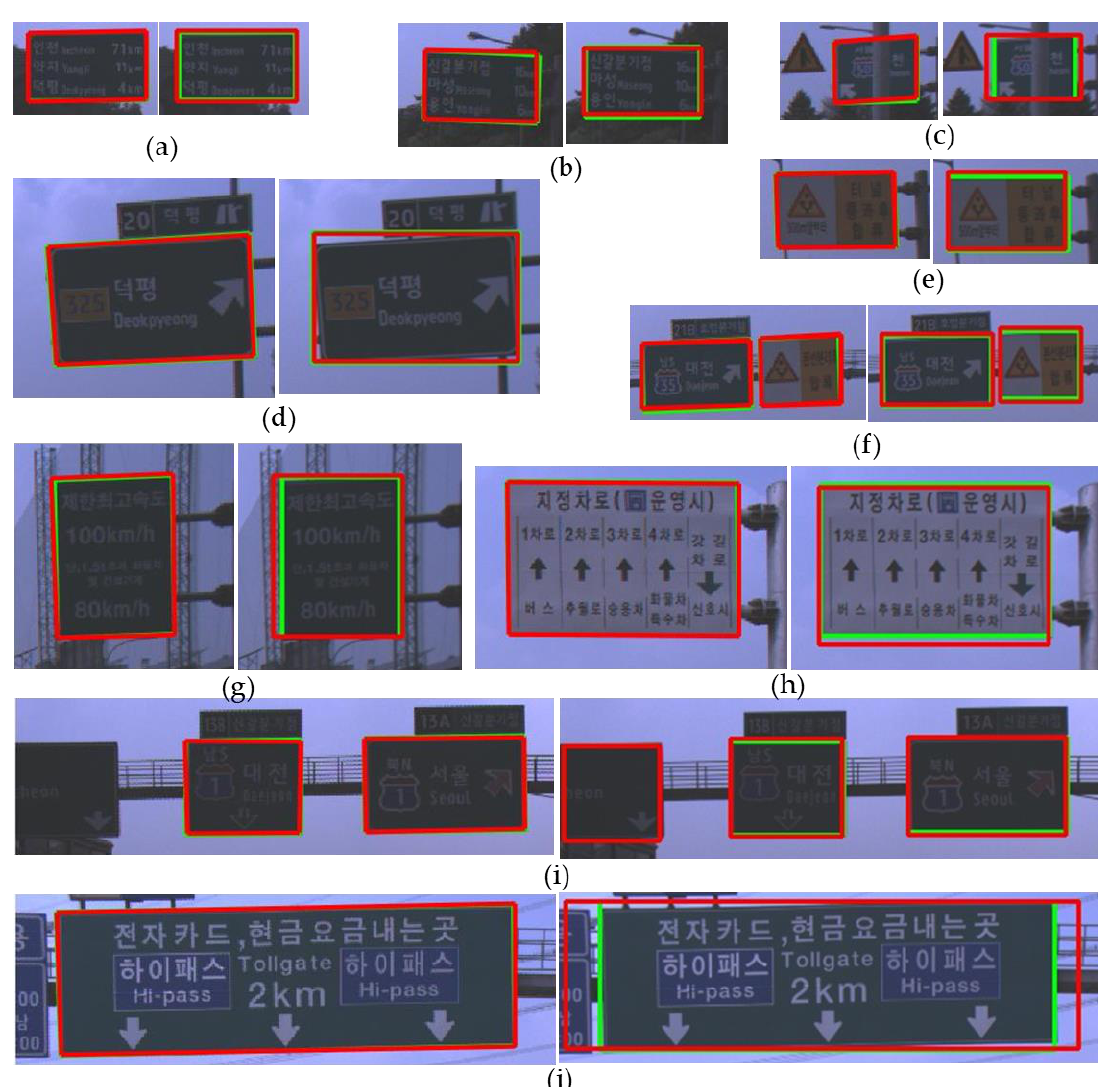
Figure 13. Comparison of the true positive detections between the proposed method and YOLOv3 (left: the proposed method, right: YOLOv3). ( a ) low contrast between a road sign and background, ( b ) low contrast between a road sign and background, ( c ) a partially occluded road sign, ( d ) a rotated road sign, ( e ) a road sign consisting of two colors, ( f ) two road signs whose kinds are different, ( g ) a road sign whose aspect ratio is small, ( h ) a white road sign, ( i ) a road sign partially observed, ( j ) a road sign whose aspect ratio is large.